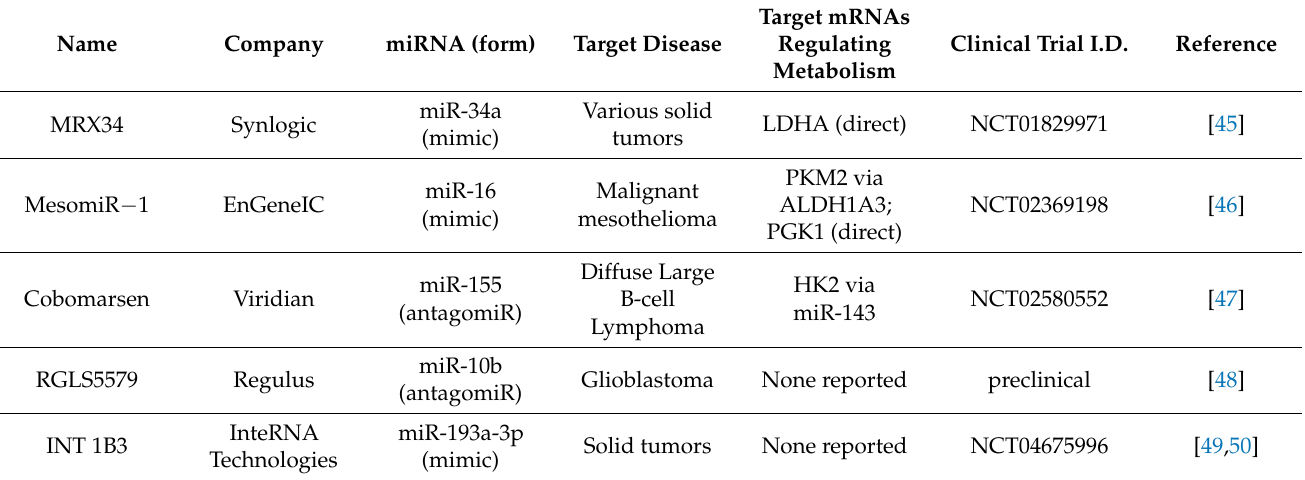
Table 1. Anti-cancer miRNA therapeutics in clinical